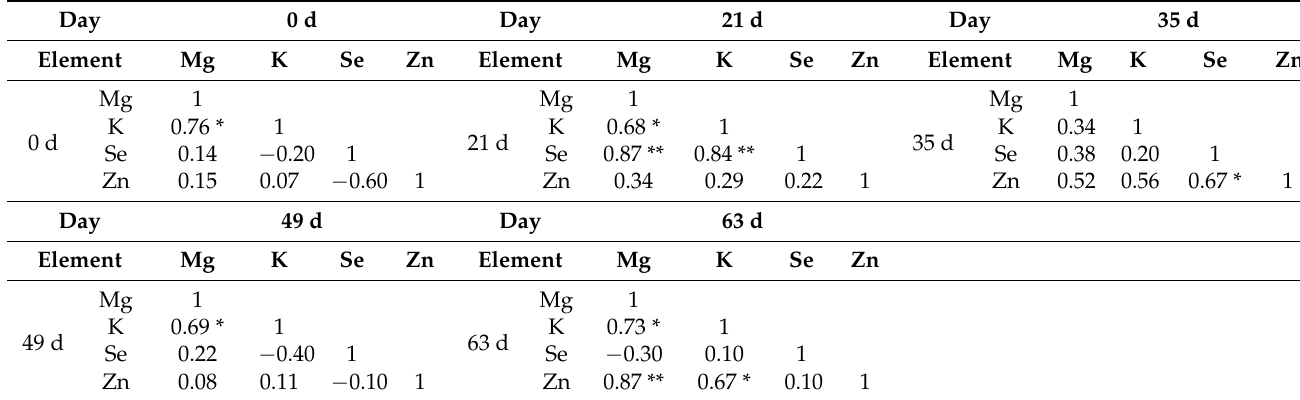
Table 5. Correlation between the depositions of mineral elements in the liver.